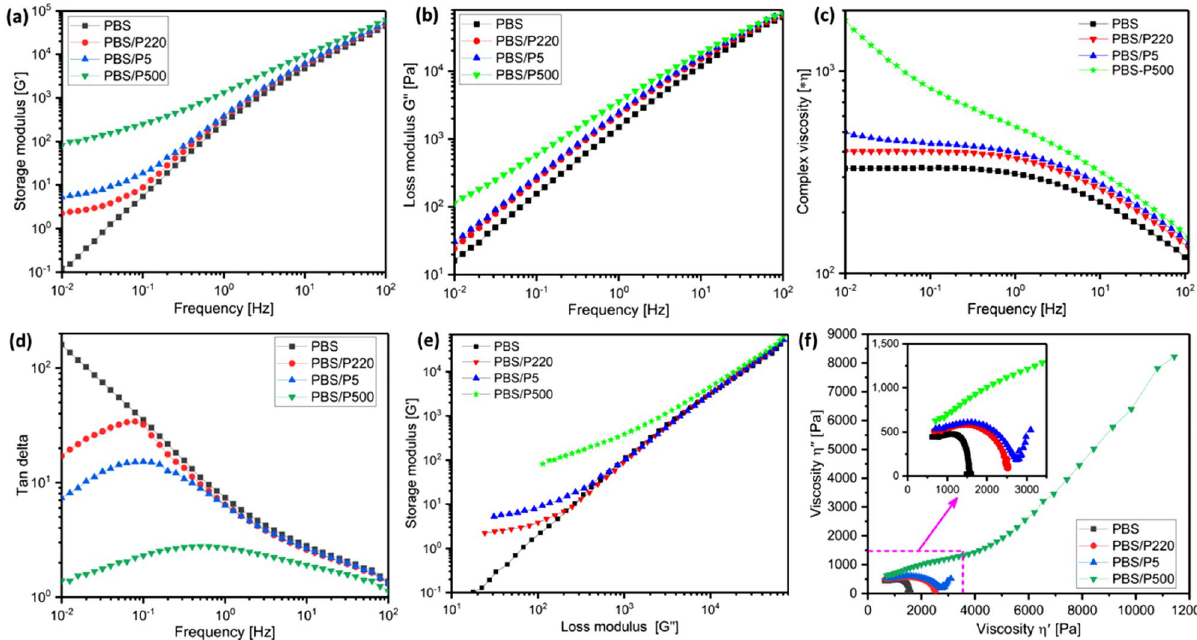
Figure 7. ( a ) Frequency dependence of the storage modulus (G ′ ) and ( b ) loss modulus (G ″ ) at 130 °C, ( c ) frequency dependence of the complex viscosity (η*), ( d ) frequency dependence of the loss tangent (tan δ = G ″ /G ′ ), ( e ) G ′ –G ″ Han curves, and ( f ) cole–cole curves for neat PBS and PBS/PTFE